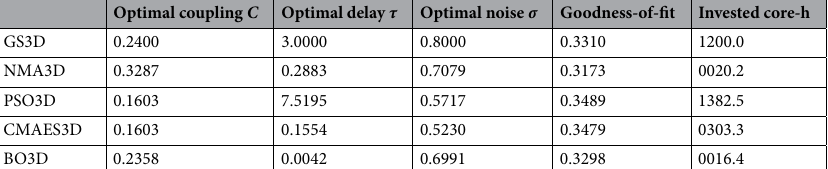
Table 2. Optimal parameter points, goodness-of-fit and the used computation time for the results presented in Fig. 2. The indicated parameter values (coupling, delay and noise) and the goodness-of-fit pertain to the best solution (highest goodness-of-fit) found across all 15 algorithm runs for the four optimization methods (NMA3D, PSO3D, CMAES3D, BO3D). For the grid search in 3Dim (GS3D), the best parameter constellation obtained from a single parameter space scan is shown. The invested core-hours (core-h) for GS3D and the optimization methods represent the required resources for one thorough scan and all 15 runs in total,